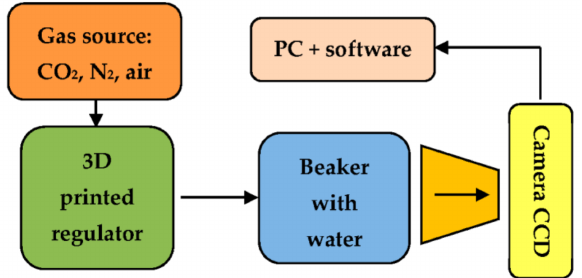
Figure 3. Measurement setup scheme for evaluation of flow values. PC: personal computer.